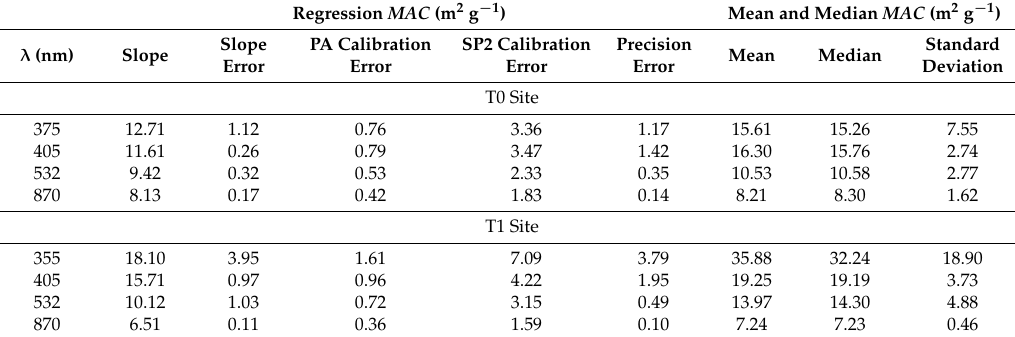
Table 1. Regression, mean, and median values of black carbon (BC) mass-normalized absorption cross-section (MAC) for 22–28 June 2010 at T0 and T1. Also included in the table are the standard deviation (SD) for the mean and median MAC values, and the slope error (SE) of MAC values from regression analysis. The total error in the regression MAC values is obtained by using the error propagation technique to the SE and calibration uncertainties of the photoacoustic (PA) and single particle soot photometer (SP2)